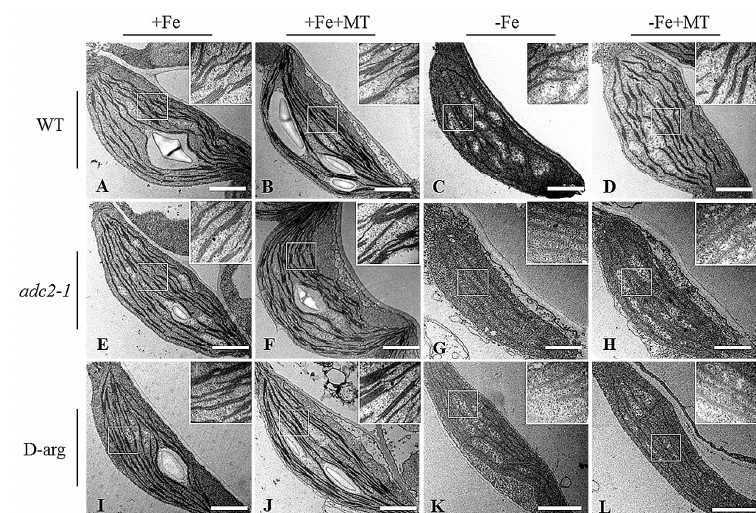
Figure 3. Transmission electron micrographic (TEM) analyses of the effect of exogenous melatonin on the chloroplast ultrastructure in the WT ( A – D ), adc2-1 ( E – H ), and D -arg-treated ( I – L ) Arabidopsis plants. Seven-day-old seedlings were treated with or without 5 μ M melatonin in the presence or absence of 50 μ M Fe for 8 days. Then the leaves from these plants were sampled to analyze the chloroplast ultrastructure: ( A , E , I ), +Fe; ( B , F , J ), +Fe + MT; ( C , G , K ), − Fe; ( D , H , L ), − Fe + MT; Scale bar = 1 μ m.